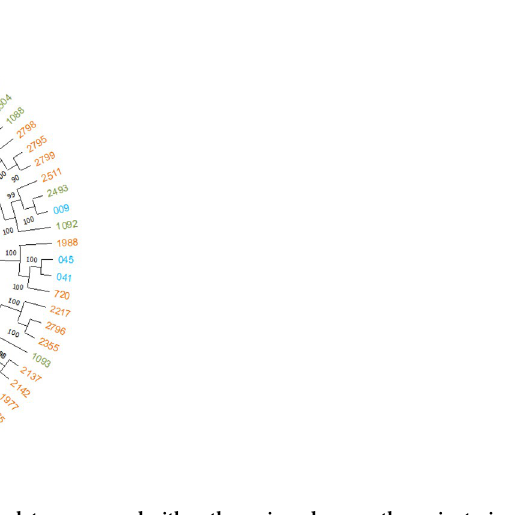
Fig 2. Phylogenetic relationships of B . cereus isolates sequenced with pathogenic and non-pathogenic strains sequences. In blue color isolates recovered in this study, in orange and green colors non-pathogenic strains and pathogenic strains,